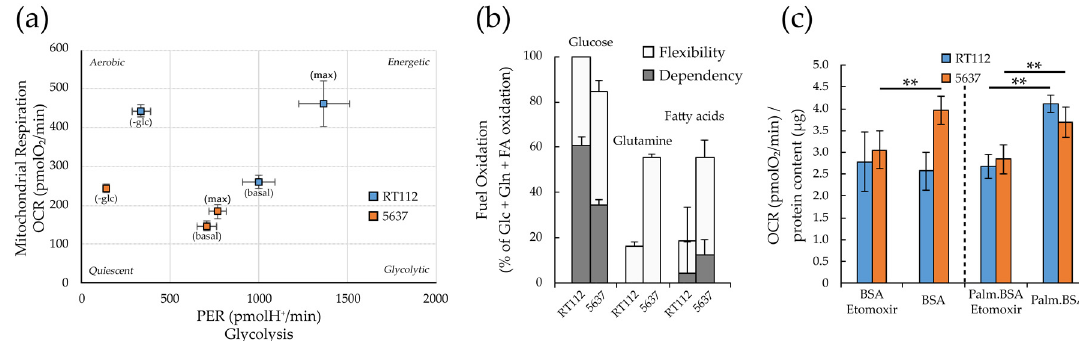
Figure 6. Glycolytic and respiratory capacity and nutrient usage in RT112 and 5637 cells. ( a ) PER and OCR values (attributable to glycolysis and oxidative phosphorylation respectively) in basal condition, maximal capacity (reached with treatment with optimized concentration of oligomycin A for maximal glycolytic capacity or FCCP for maximal respiratory capacity) and under 5 h-glucose